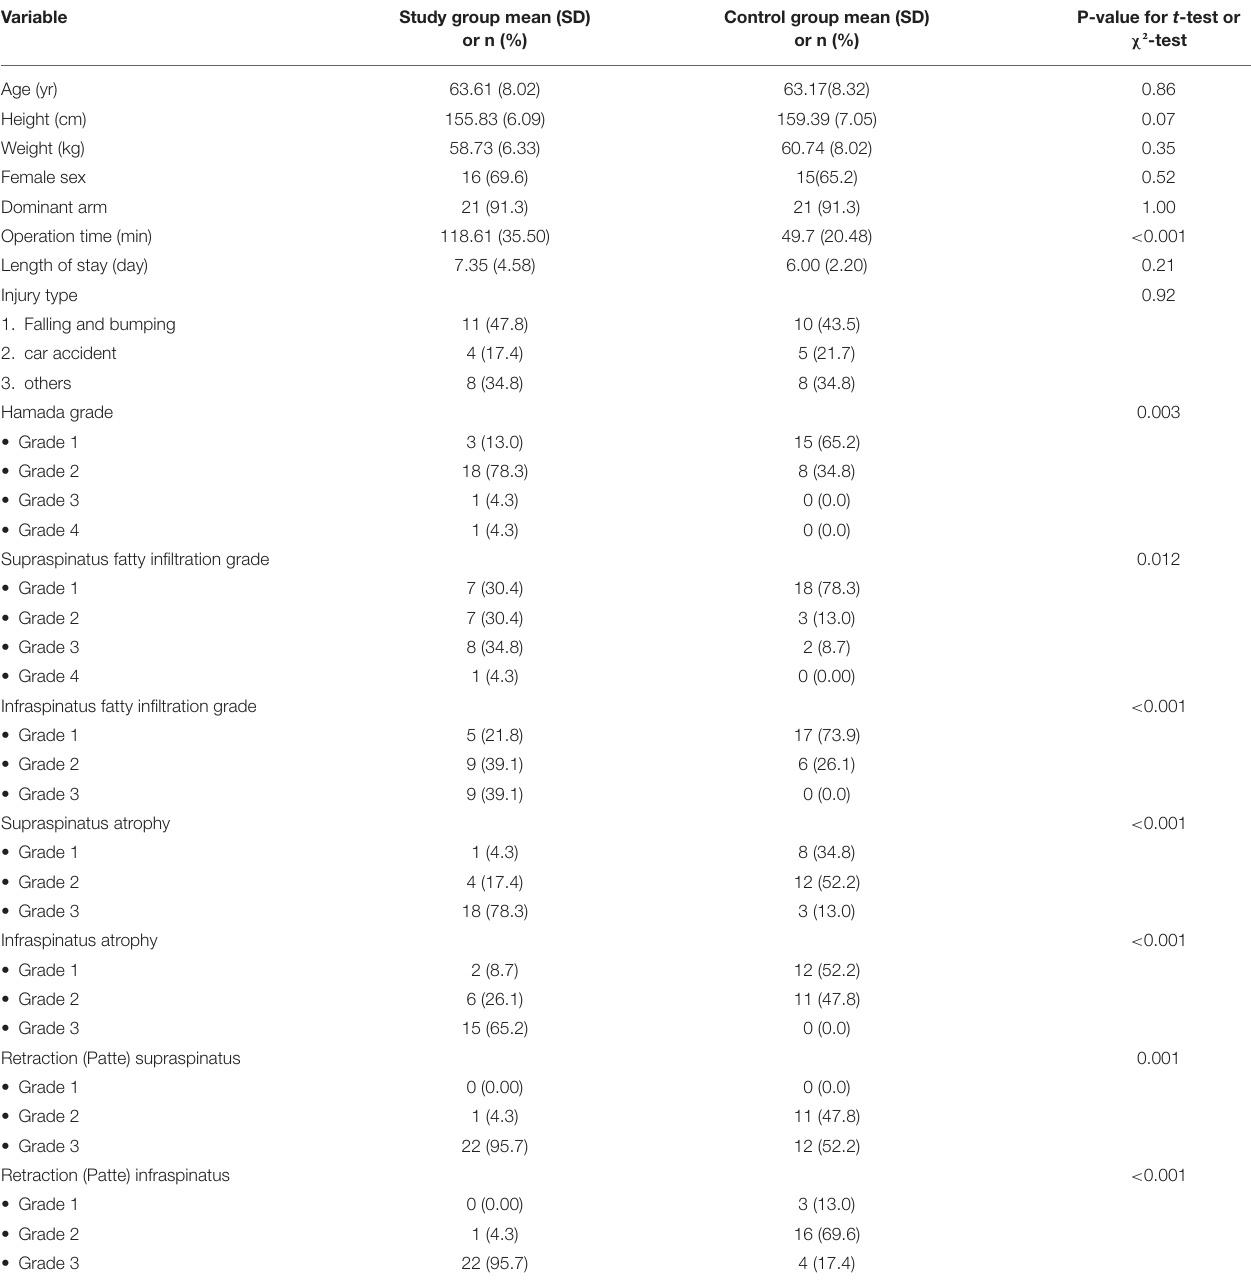
TABLE 1 | Basic information of patients and operation data statistics.